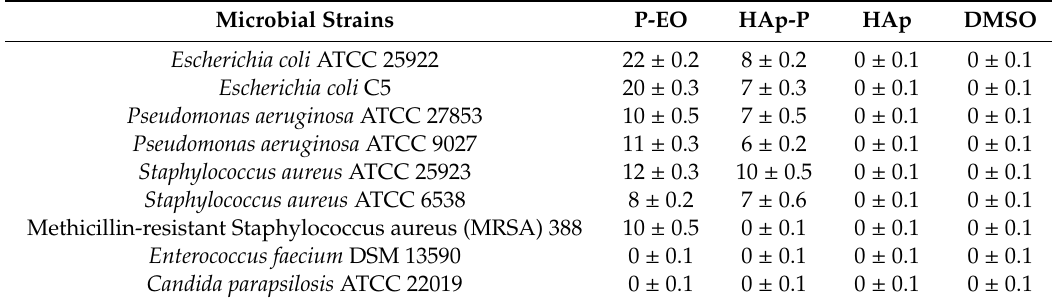
Table 1. The diameters of inhibition growth zones (mm).